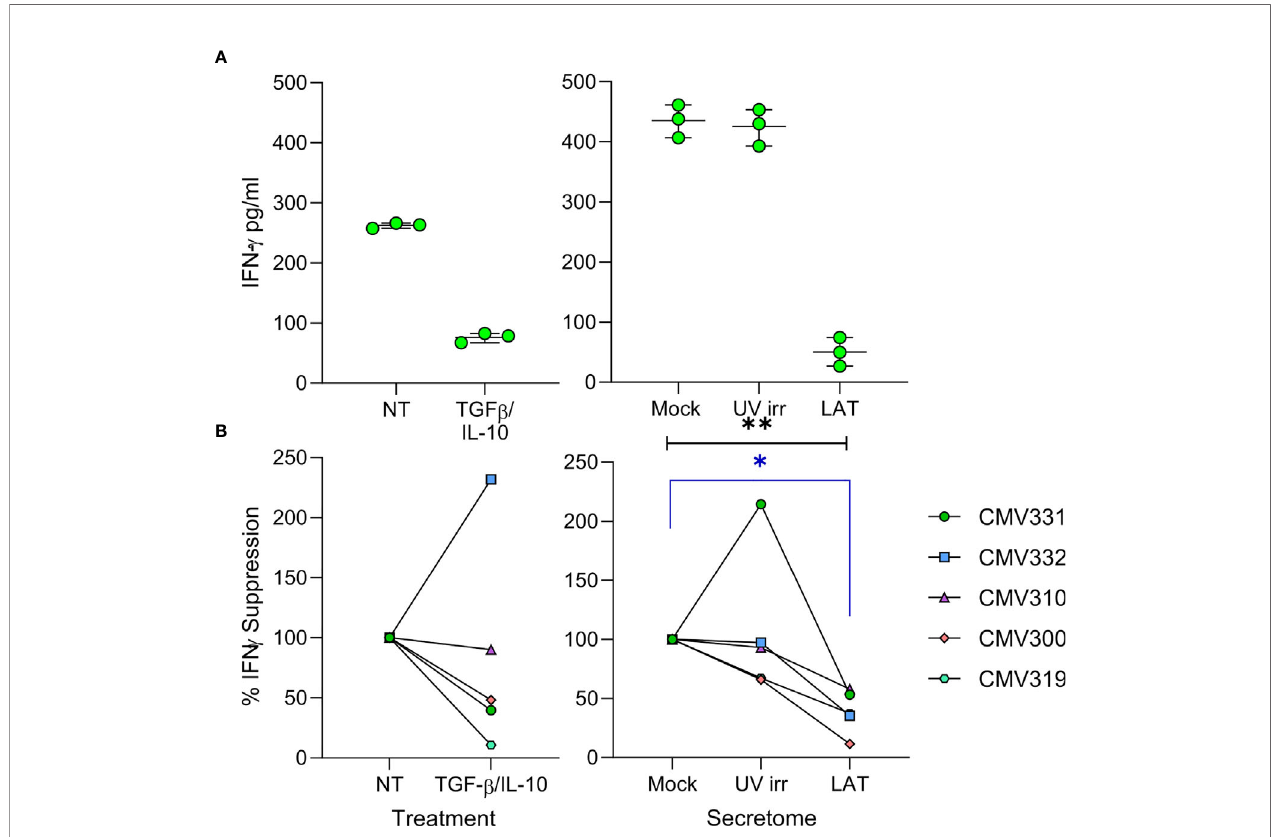
FIGURE 5 | The latent infected monocyte secretome inhibits the production of IFN g in response to polyclonal activation. CD4+ T cells were resuspended in either X- VIVO Media (Not Treated (NT)), media with added recombinant protein TGF b & IL-10 (TGF b /IL-10), Mock, UV irradiated (UV irr) or Latent infected (LAT) secretomes; following 24 hours pre-treatment the CD4+ T cells were stimulated with a mixture of anti-CD3 and anti-CD28 for a further 24 hours and then supernatants harvested. Production of IFN g in the supernatants was measured by ELISA, representative results from one donor are shown (A) . Summary graphs showing the percentage suppression by either TGF b /IL-10 treatment or the Latent infected monocyte secretomes of polyclonally stimulated CD4+ T cells from 5 donors (B) . The Latent infected secretomes signi fi cantly suppressed the production of IFN g by polyclonal stimulation (Friedman matched 1-way ANOVA test (black line p=0.0085**) and Dunn ’ s corrected post-test (blue line